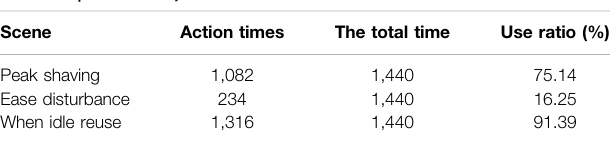
TABLE 5 | ES ef fi ciency.